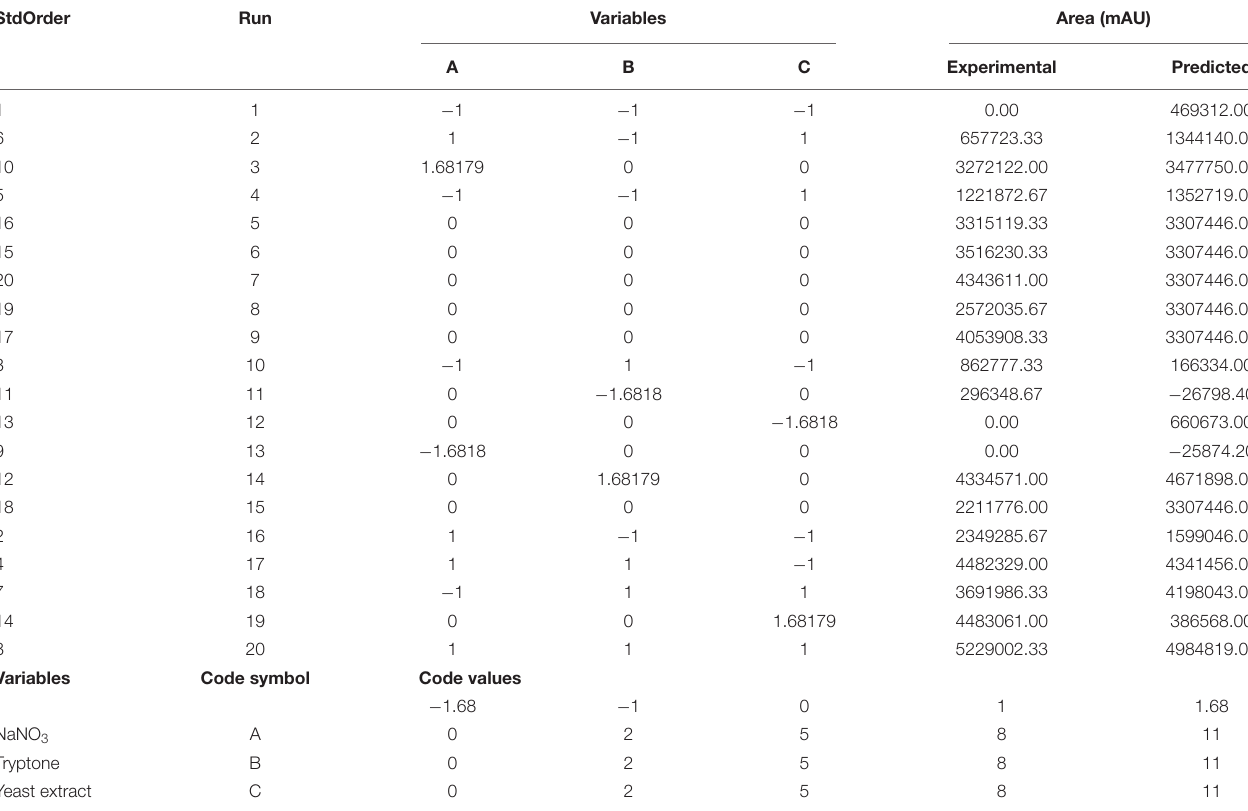
TABLE 5 | Matrix of the central composite design and the corresponding experimental and predicted concentrations of cyclopiazonic acid produced by Penicillium commune KACC 45973. StdOrder Run Variables Area (mAU)